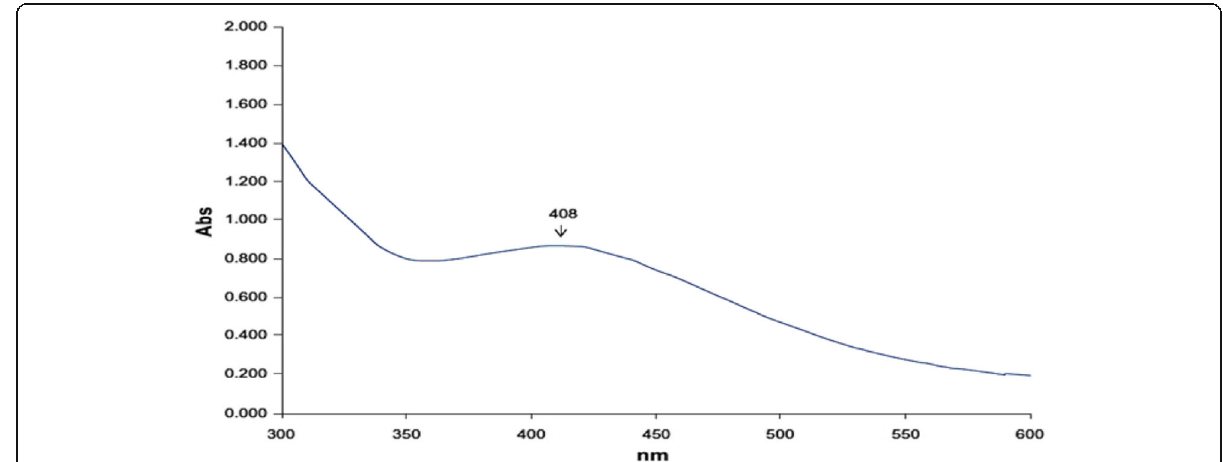
1654.92 cm − 1 (curve-1) and 1666.50 cm − 1 (curve-2). The peak found at 1470.50 cm − 1 (curve-1) and 1479.40 cm − 1 (curve-2) correspond to – CH scissoring. The band observed at 1384.89 cm − 1 (curve-2) repre- sent N = O stretching of nitro groups and 1253.73 cm − 1 (curve-2) indicate the presence of alkyl halide or alcohol group in fruit extract coated on nanoparticles. The aris- proper coating of leaf extract on silver nanoparticles. The bands at 1130.29 cm − 1 (curve-2) denoted -C-H stretching vibration of ester. Beside, C-O stretch oc-